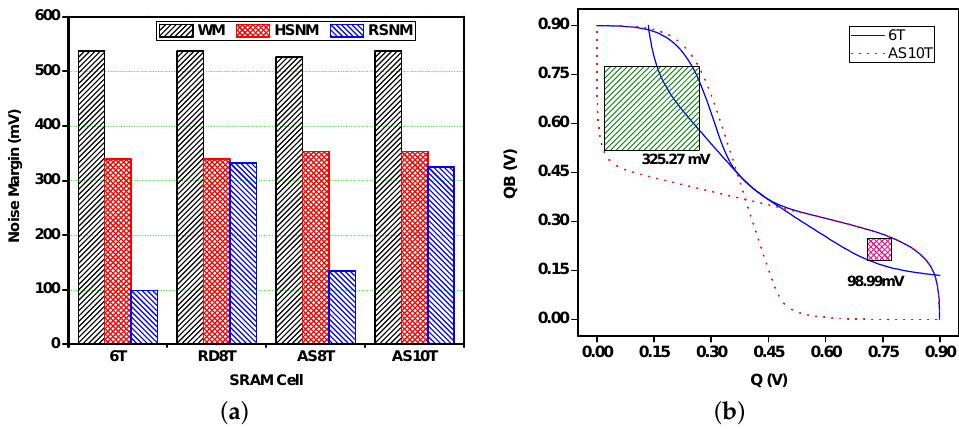
Figure 3. ( a ) Write margin (WM), hold static noise margin (HSNM), and read static noise margin (RSNM) of different SRAM cells; ( b ) Butterfly curve for read operation and RSNM of the 6T and AS10T SRAM cells. The margins are calculated considering a supply voltage of V dd = 0.9V and T = 25 ◦